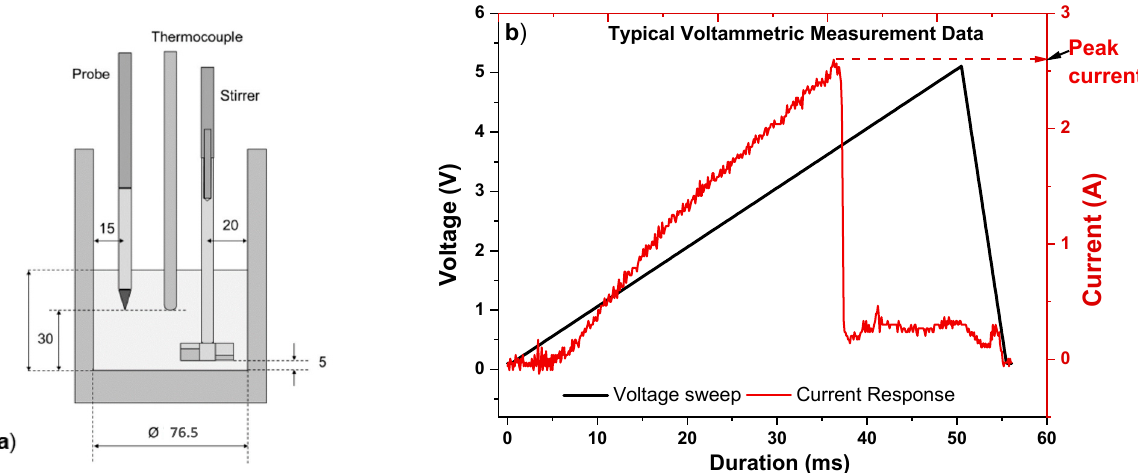
Figure 1. Experimental setup and data: ( a ) experimental setup for the dissolution test, dimensions are in millimetres; ( b ) typical voltammetric measurement data from the dissolution tests.